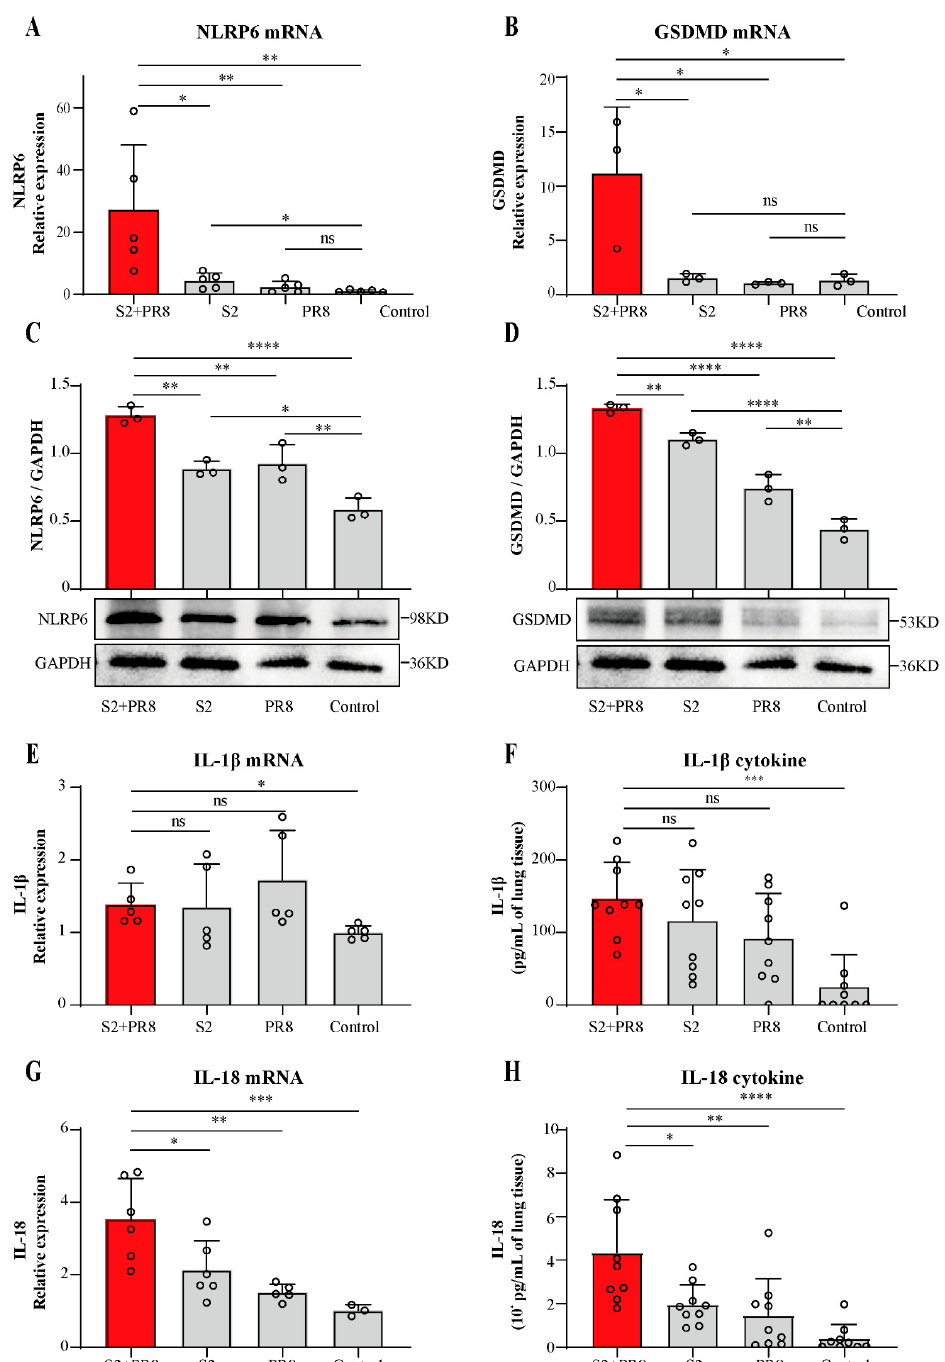
Figure 2. The expression levels of NLRP6, GSDMD, IL-1 β , and IL-18 in WT mice. ( A – D ) The overexpression of NLRP6 and GSDMD was caused by coinfection in the lungs. The mRNA expression was measured with qPCR, and the protein expression was detected with Western blot. Two-tailed unpaired Student’s t -test was used to compare two groups, and one-way ANOVA was used to compare three groups or more. ( E – H ) The expression of IL-1 β and the overexpression of IL-18 were caused by coinfection in the lungs. The mRNA expression was measured with qPCR, and the cytokines were measured with ELISA. Two-tailed unpaired Student’s t -test were used to compare two groups, and one-way ANOVA was used to compare three groups or more. Results expressed as mean ± standard; * p < 0.05; ** p < 0.01; *** p < 0.001; and **** p <